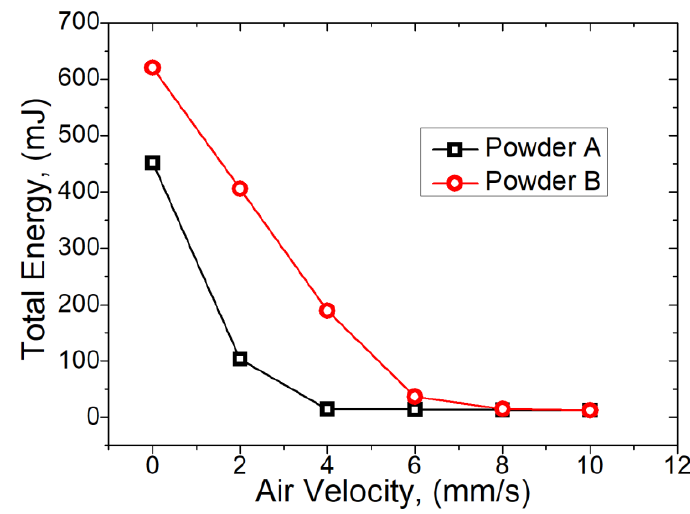
Figure 4. Comparison of fluidization characteristics for Powder A ( ) and Powder B ( ).